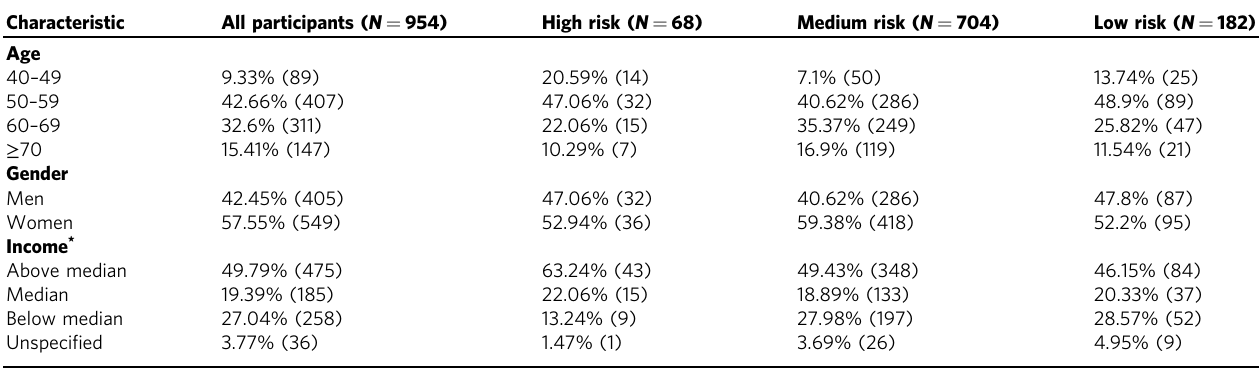
Table 1 Characteristics of the study